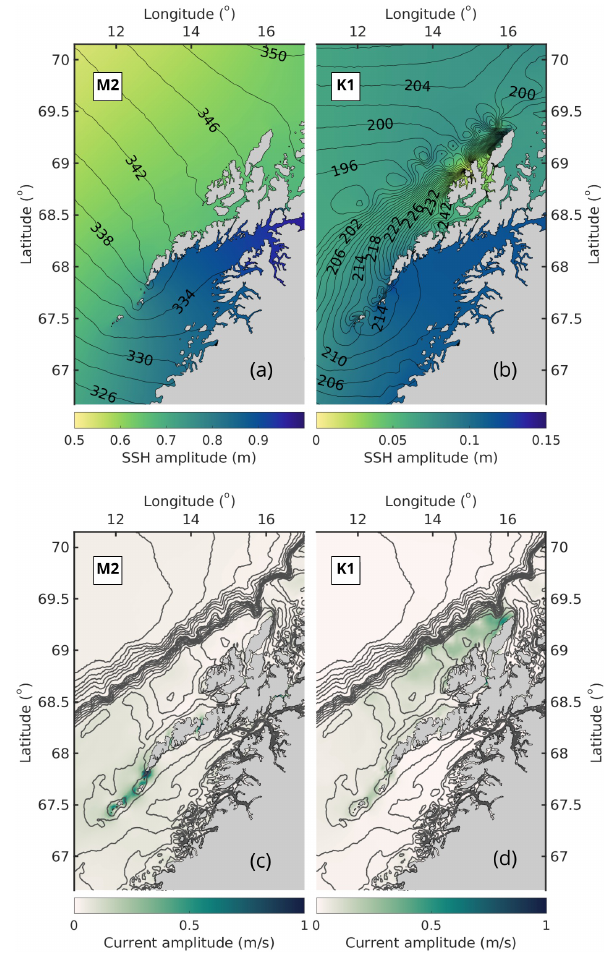
Figure 6. The M2 (a, c) and K1 (b, d) tide in the model. The upper panels show the amplitude (color) and phase (contours) of SSH for the two constituents. Panels (c) and (d) show the magnitude of the major axis of tidal currents (colors) and bottom topography (con-